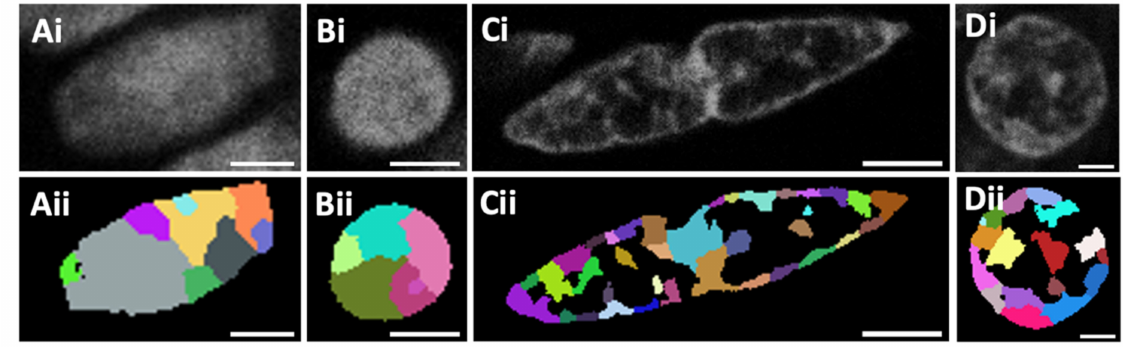
Figure 1. Representative confocal images of human colorectal tissue nuclei stained with Sytox Orange dye. ( Ai – Ci ) Images from a normal colorectal tissue sample comprising a nucleus from the mucosa (normal epithelial cell) ( Ai ), the submucosa ( Bi ) and the muscularis ( Ci ) layer. An image from a colorectal carcinoma tissue sample shows a carcinoma cell nucleus from the tumour region ( Di ). Resulting images for each cell type after the segmentation analysis was performed ( Aii – Dii ). Scale bars: 3 µ m.